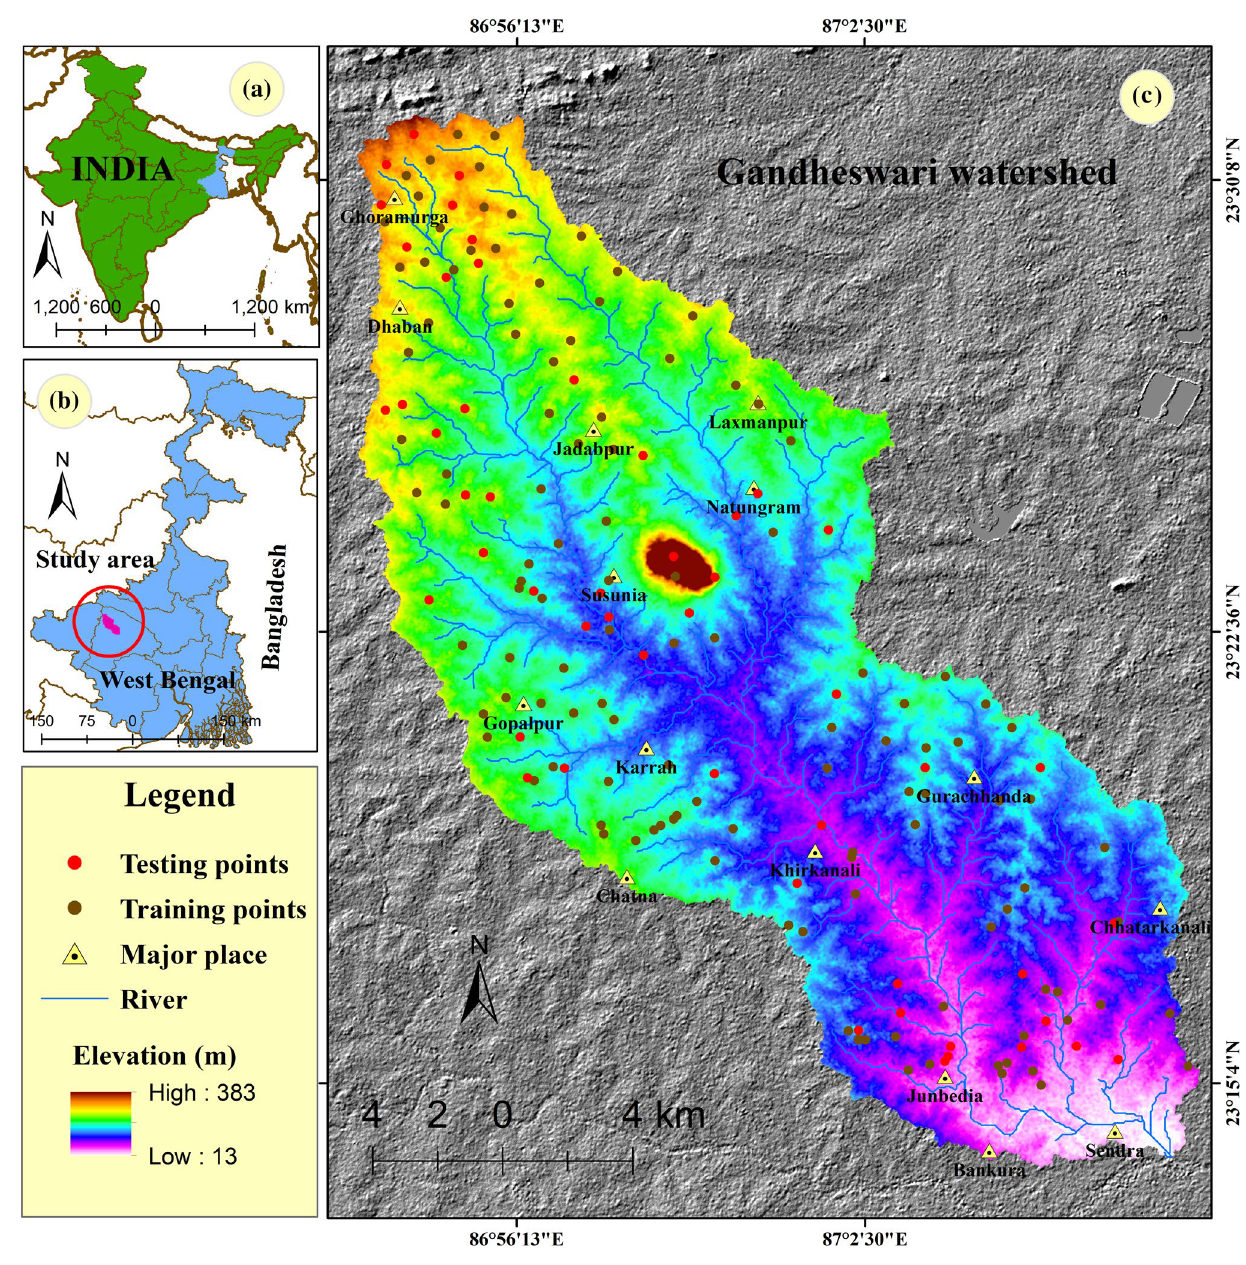
Fig. 1 Location of the study area: a India, b West Bengal, and c Gandheswari